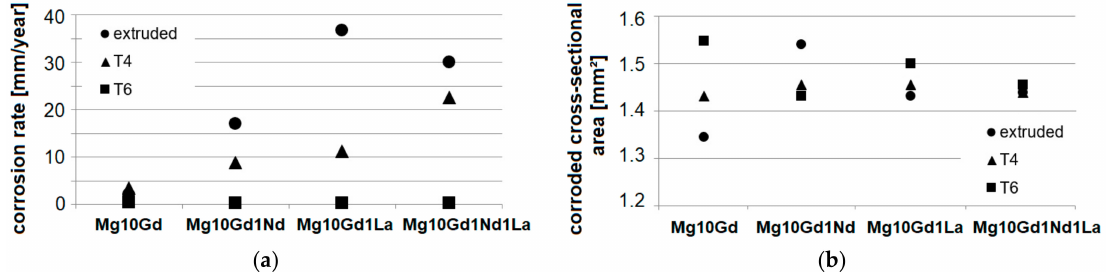
Figure 13. Corrosion rate and corroded area influenced by alloy and material condition: ( a ) corrosion rate by immersion, and ( b ) corroded area by polarization.